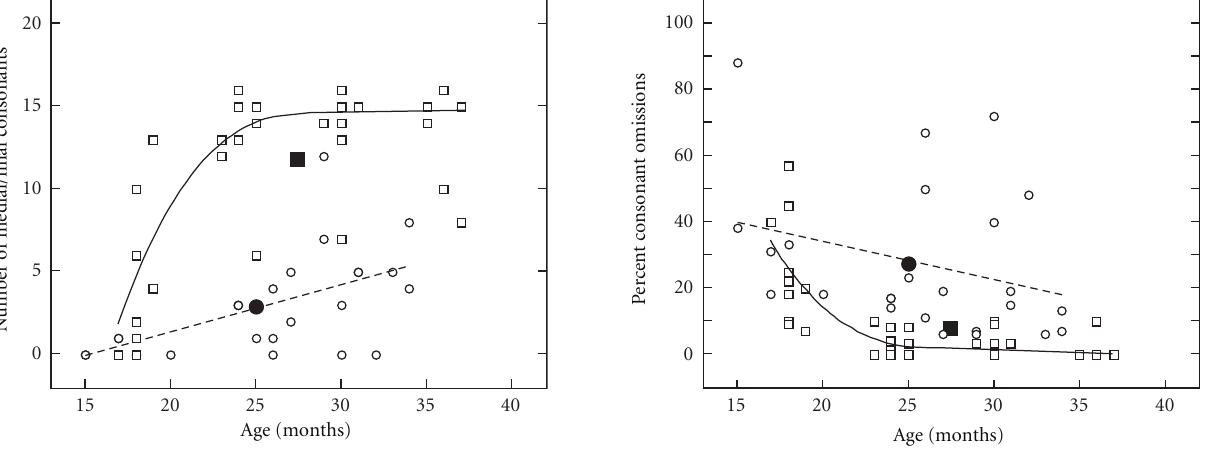
Figure 4: Percent of consonant omissions determined from the PEEPS for the children with CLP (circles) and NC children (squares) across the ages of 18 to 36 months. The linear (CLP: dotted line) and curvilinear (NC: solid line) polynomials and means (filled symbols) are displayed for the groups.